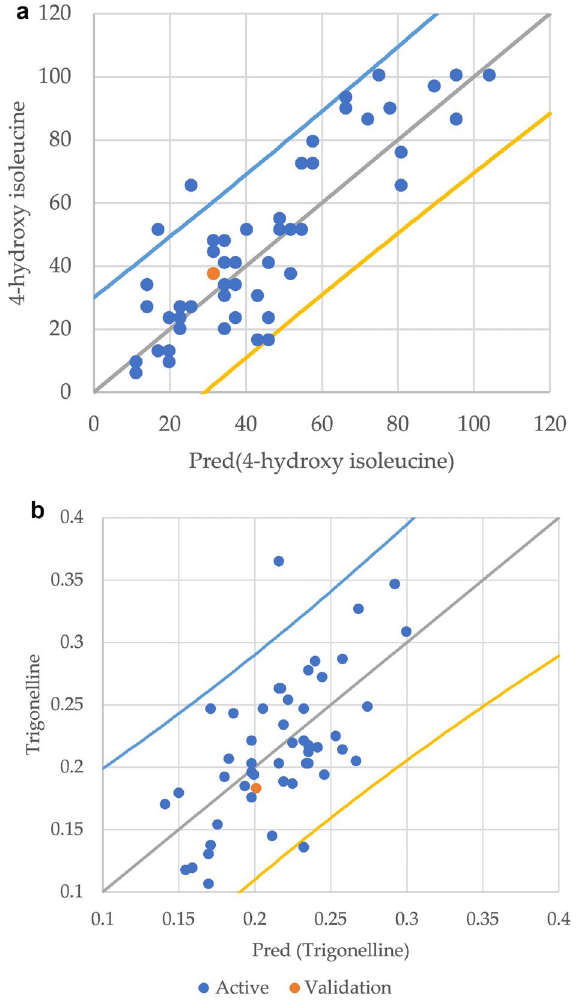
Figure 3. Observed and cross-validated predicted values of 4-hydroxyisoleucine ( a ) and trigonelline ( b ). Each point shows one region. The root mean square error of prediction (RMSEP) indicates the quality of the model in predicting 4-hydroxyisoleucine and trigonelline content. The regression coefficient (R2) indicates the fit between the predicted and observed 4-hydroxyisoleucine and trigonelline